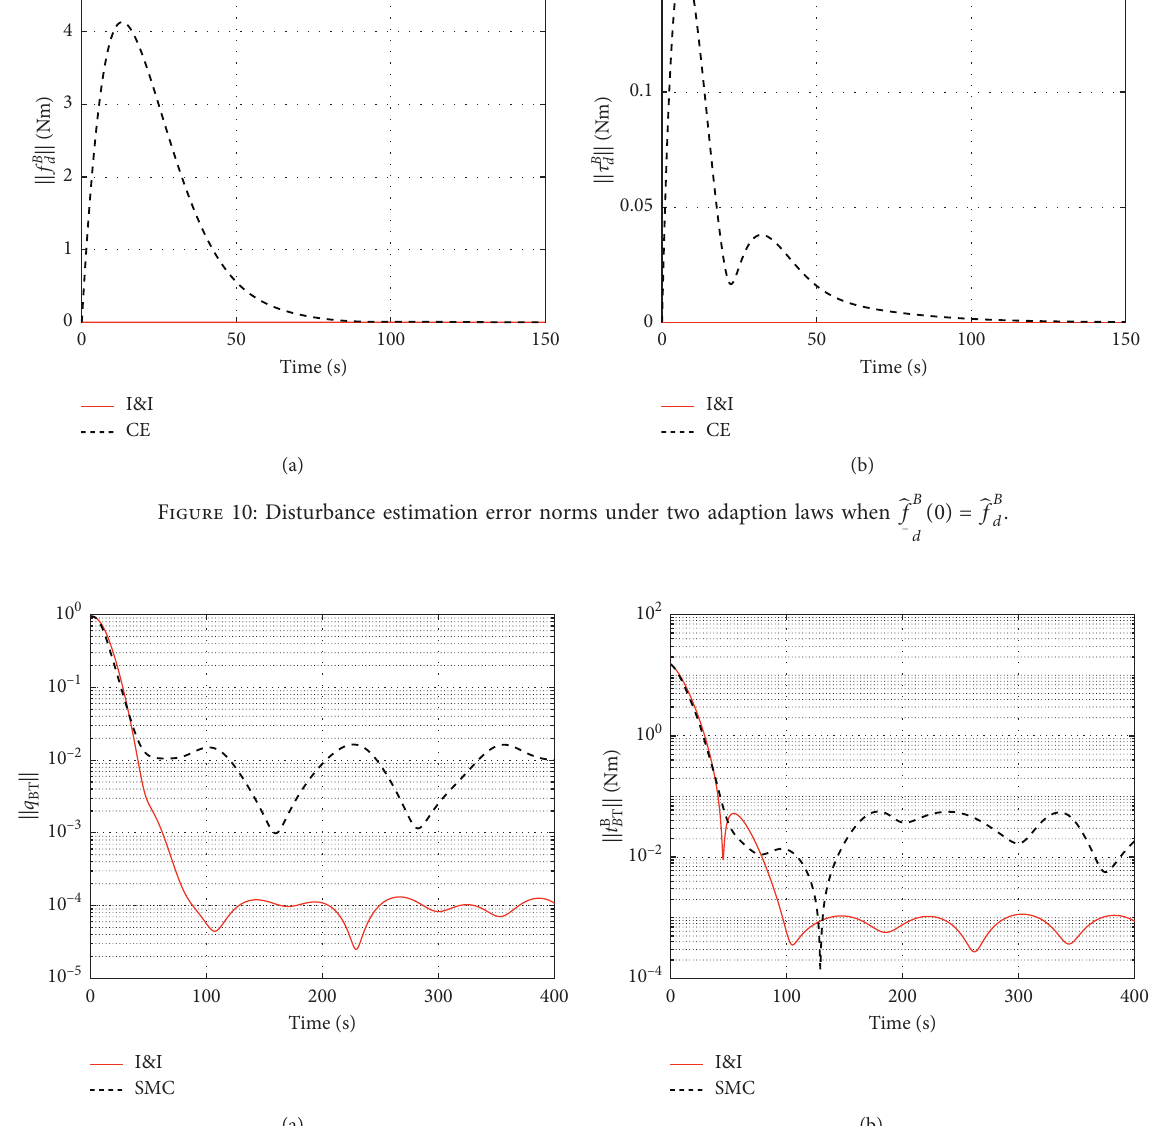
Figure 11: Relative pose norms under different controllers.